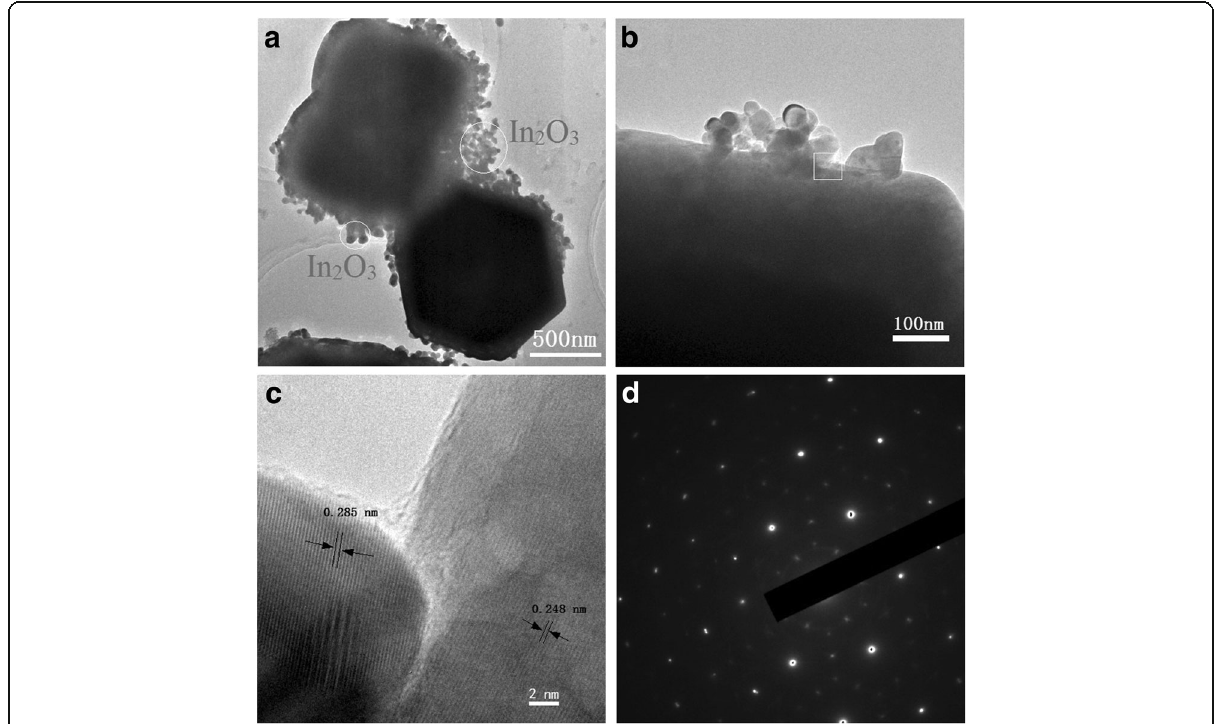
Fig. 3 TEM image ( a ) and HR-TEM images ( b , c ) of Zn-In-4 sample